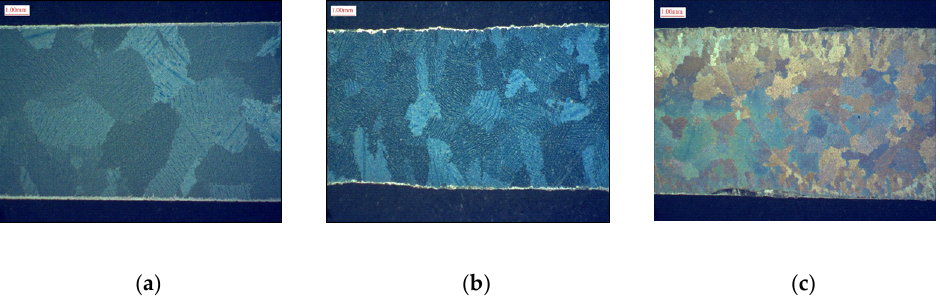
Figure 3. The appearance of samples before ( a ) and after corrosion tests (( b , c )—sample No. 5, 6 according to the table) from the SDP3-A alloy.